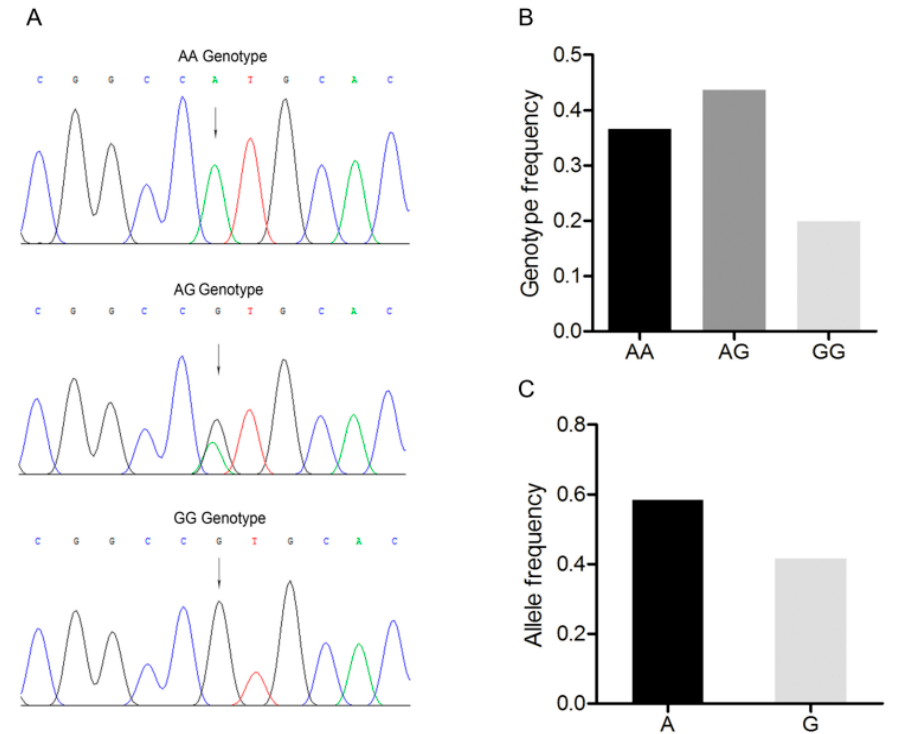
Figure 2. Mutation c.1569A > G in the 3’-untranslated region of the Large White pig BMP7 gene. ( A ) Sequence of di ff erent genotypes at the mutation c.1569A > G. The arrow indicates the substitution position. ( B ) Genotype frequency of the mutation c.1569A > G. ( C ) Allele frequency of the mutation c.1569A > G. n = 227.